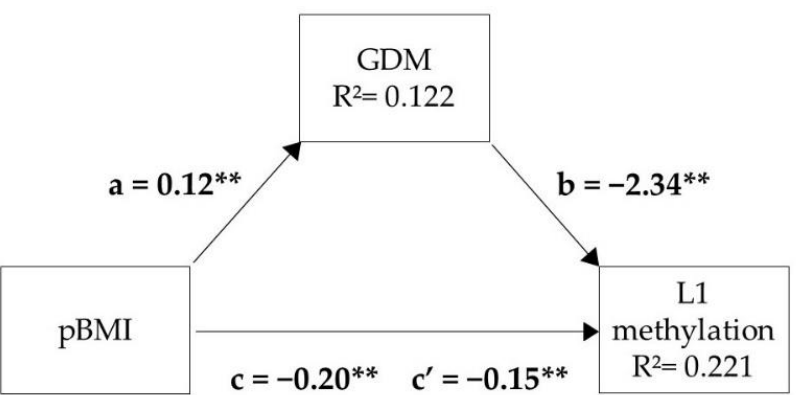
Figure 5. Simple mediation analysis model relating maternal pre-gestational body mass index (pBMI) and gestational diabetes mellitus (GDM) to HTR2A methylation at L1 site in female placentas ( n = 89). The c path coefficient represents the effect of pBMI on L1 methylation. The c’ path coefficient refers to the effect of pBMI on L1 methylation, after controlling for the mediator GDM. R 2 is the proportion of variance explained by the predictor variable in the regression model. Shown are unstandardized regression coefficients; all were statistically significant. For details, see Appendix A (Table A2). ** p < 0.01.